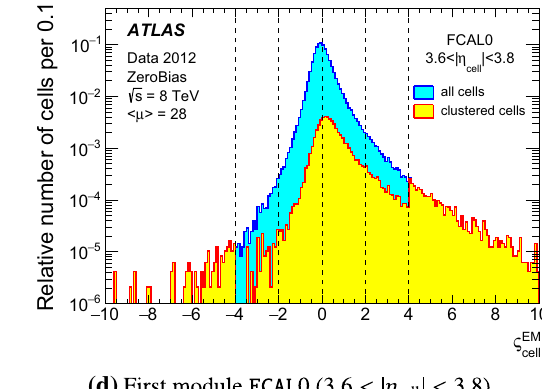
the threshold defined by P in Eq. (5), but not the one in Eq. (4), is collected. At this point the formation